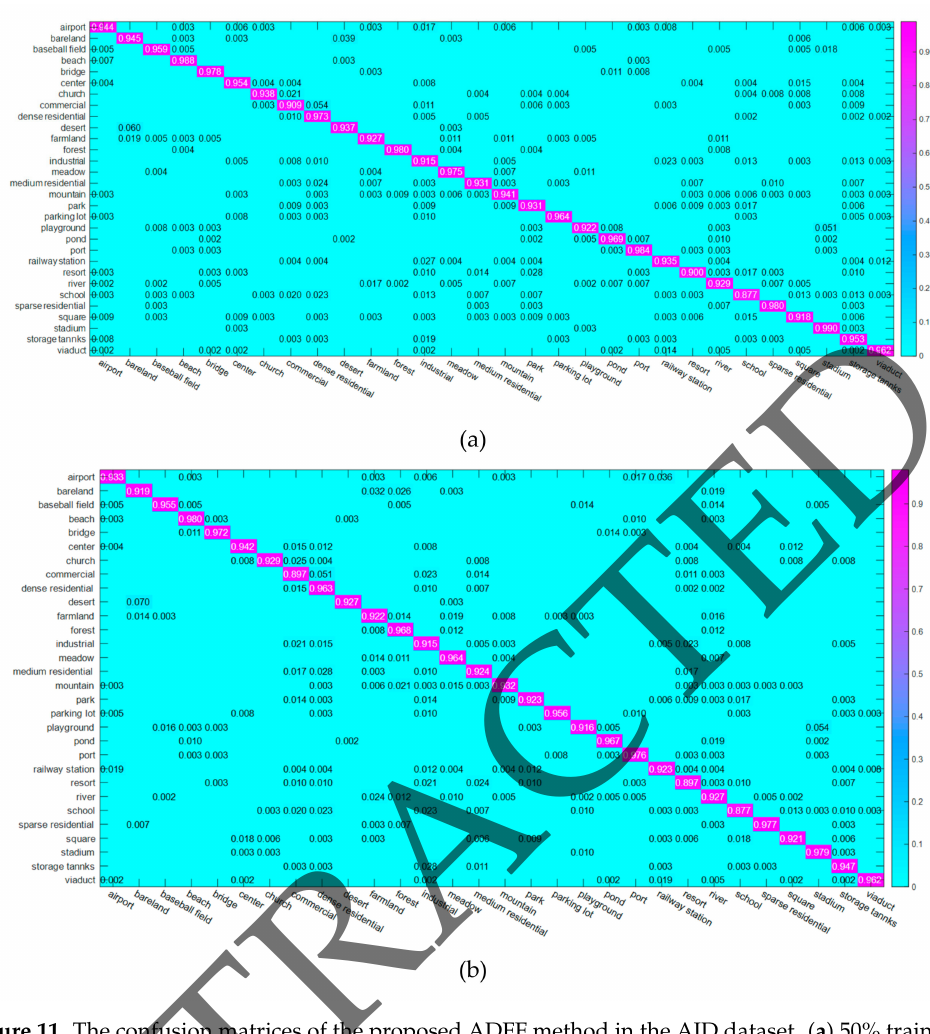
Figure 11. The confusion matrices of the proposed ADFF method in the AID dataset. ( a ) 50% training ratio. ( b ) 20% training